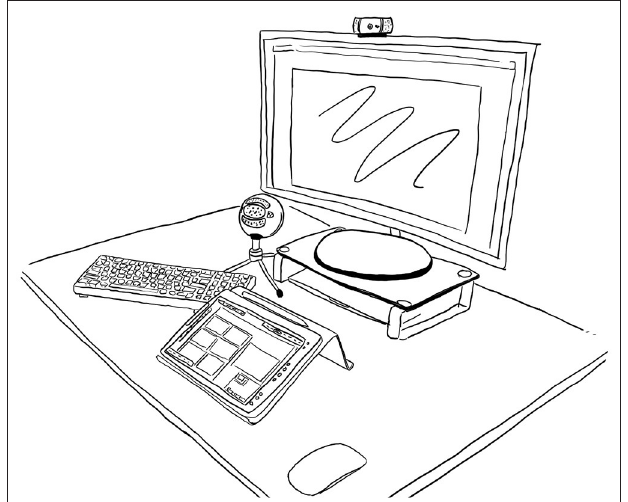
FIGURE 7 | Online learning sketching set up in a quiet, well lit, location: 27” monitor, external microphone, external webcam, external keyboard, external mouse, and Wacom Cintiq One with Pen on a laptop stand. Makayla Lewis,